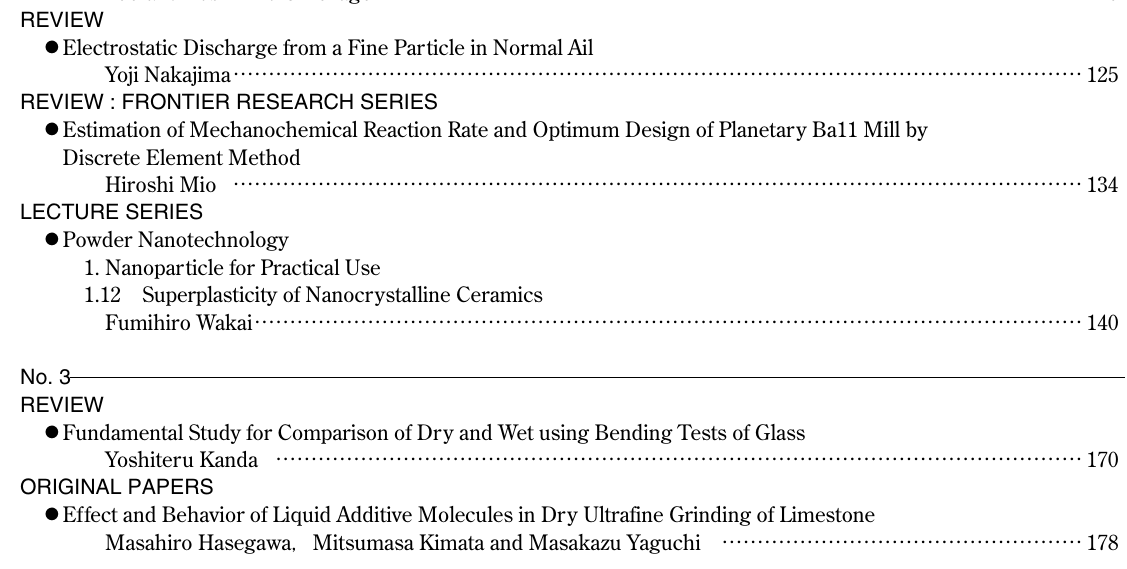
Discrete Element